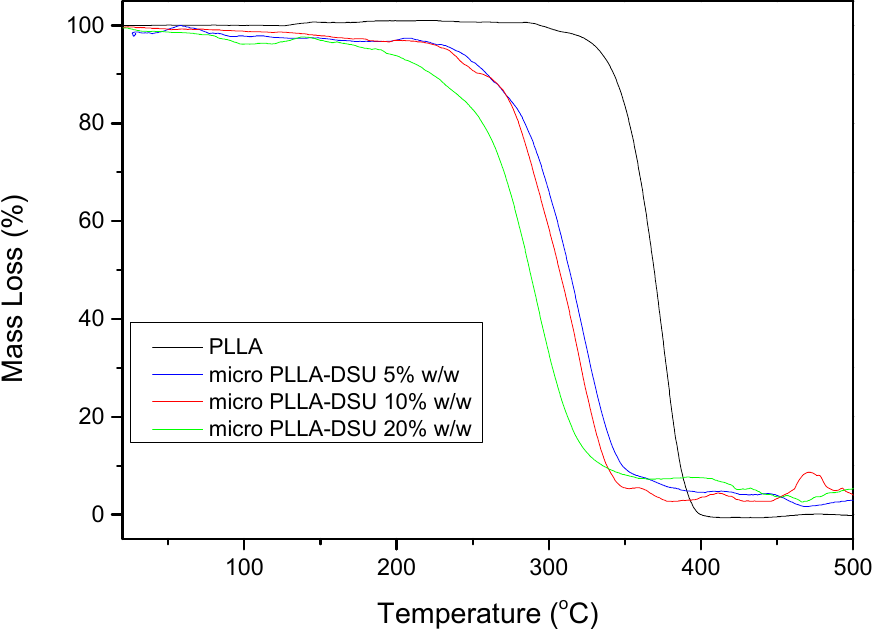
Figure 6. TGA thermographs of PLLA and PLLA-DSU microparticles.